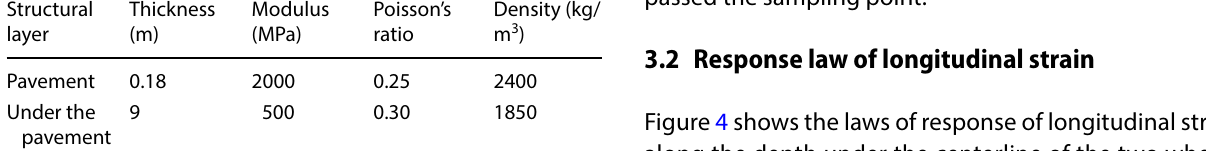
Table 4 Parameters of the structural layer Structural layer